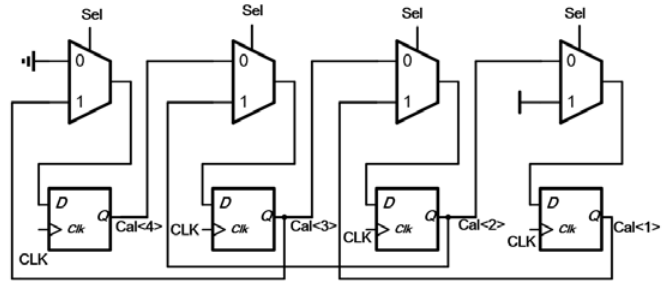
Figure 7. The 4-bit example of the bi-directional shift register (BDSR).